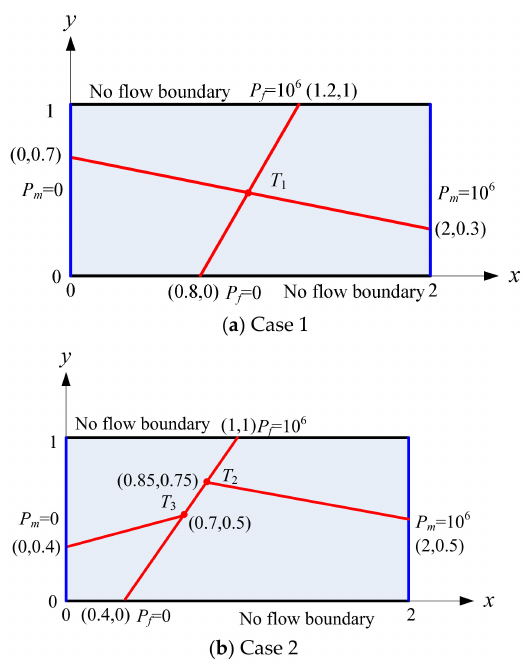
Figure 3. Geometry model of intersecting fracture cases.